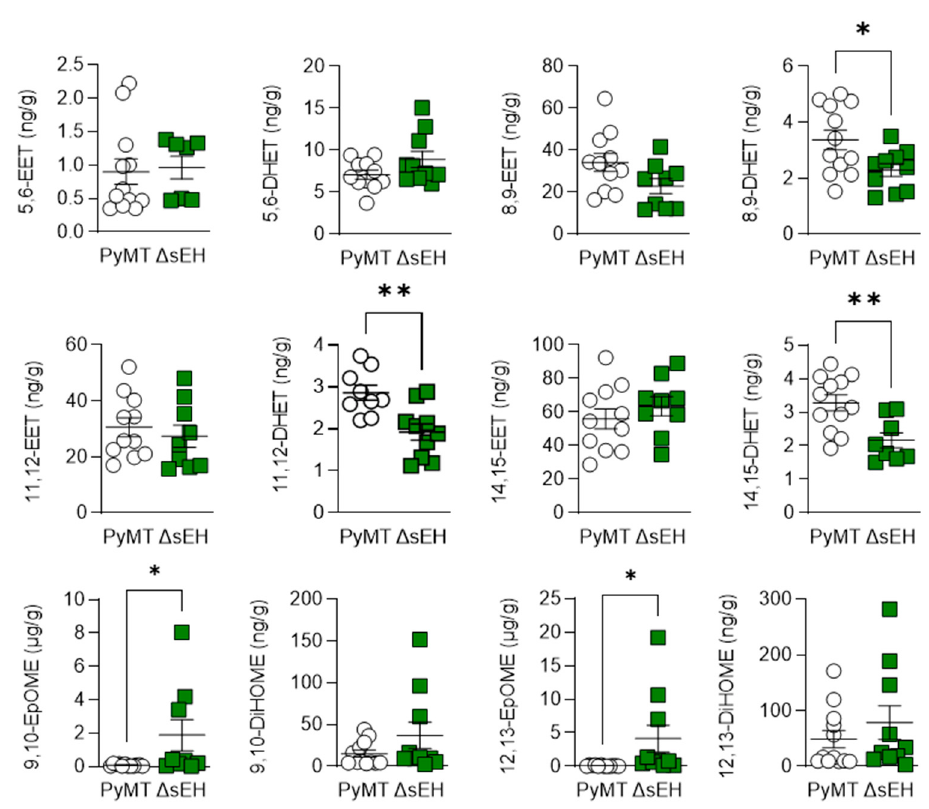
Figure 5. ω -6 PUFA epoxide and diol profiles. Primary tumors were isolated from 20-week-old PyMT and PyMT Δ sEH ( Δ sEH) mice and the PUFA epoxide and diol profiles were generated by LC–MS/MS. Note the different scale in the X axes of the EpOMEs. EET, epoxyeicosatrienoic acid; DHET, dihydroxyeicosatrienoic acid; EpOME, epoxyoctadecamonoenic acid; DiHOME, dihydroxyoctadecenoic acid. The graphs summarize data from breast tumors from 6–12 different animals in each group; * p < 0.05, ** p < 0.01 (Student’s t test). There were also changes in the epoxides and diols derived from ω -3 PUFAs, with levels of 8,9-, 17,18-epoxyeicosatetraenoic acid (EEQ) and 19,20-epoxydocosapentaenoic acid (EDP) being higher in tumors from PyMT Δ sEH versus PyMT mice (Figure 6).